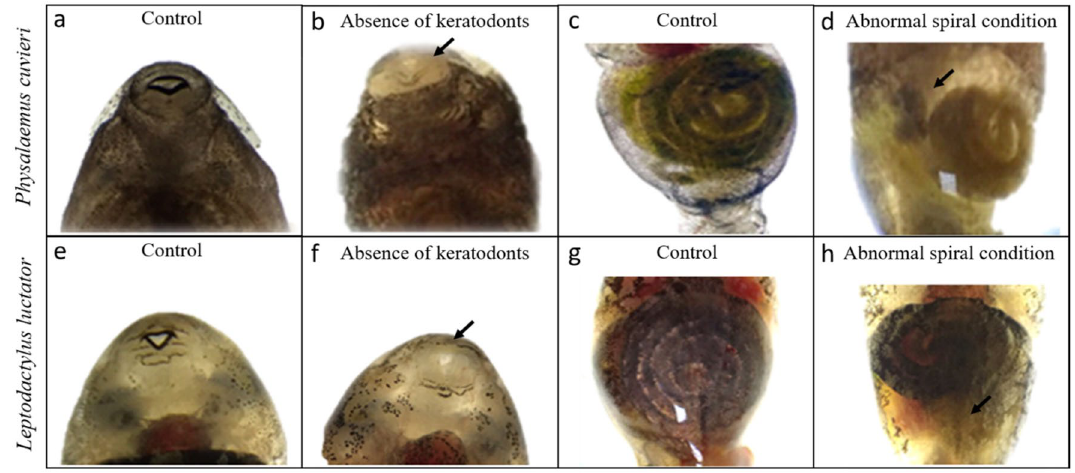
Figure 3. Tadpoles of Leptodactylus luctator ( a – d ) and Physalaemus cuvieri ( e – h ). These tadpoles represent the control group ( a , c and e , g ), and individuals exposed to different concentrations of an imidacloprid-based insecticide for 168 h: ( b ) 200 µg L −1 , malformation of the oral structures; ( d ) 200 µg L −1 , intestinal malformation; ( f ) 300 µg L −1 , malformation of the oral structures; ( h ) 300 µg L −1 intestinal malformation. (For the color version of figure, the reader is referred to the web version of this article).